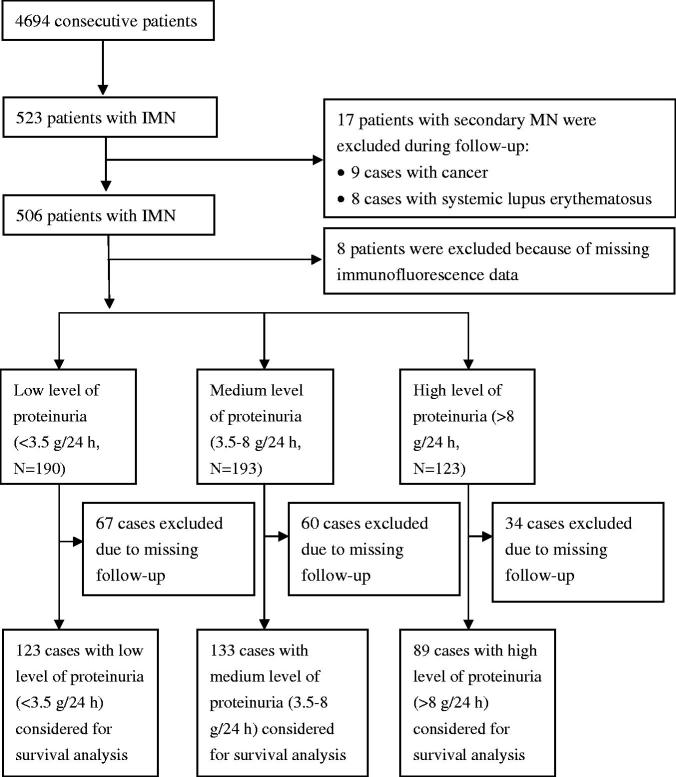
Patient selection flowchart.